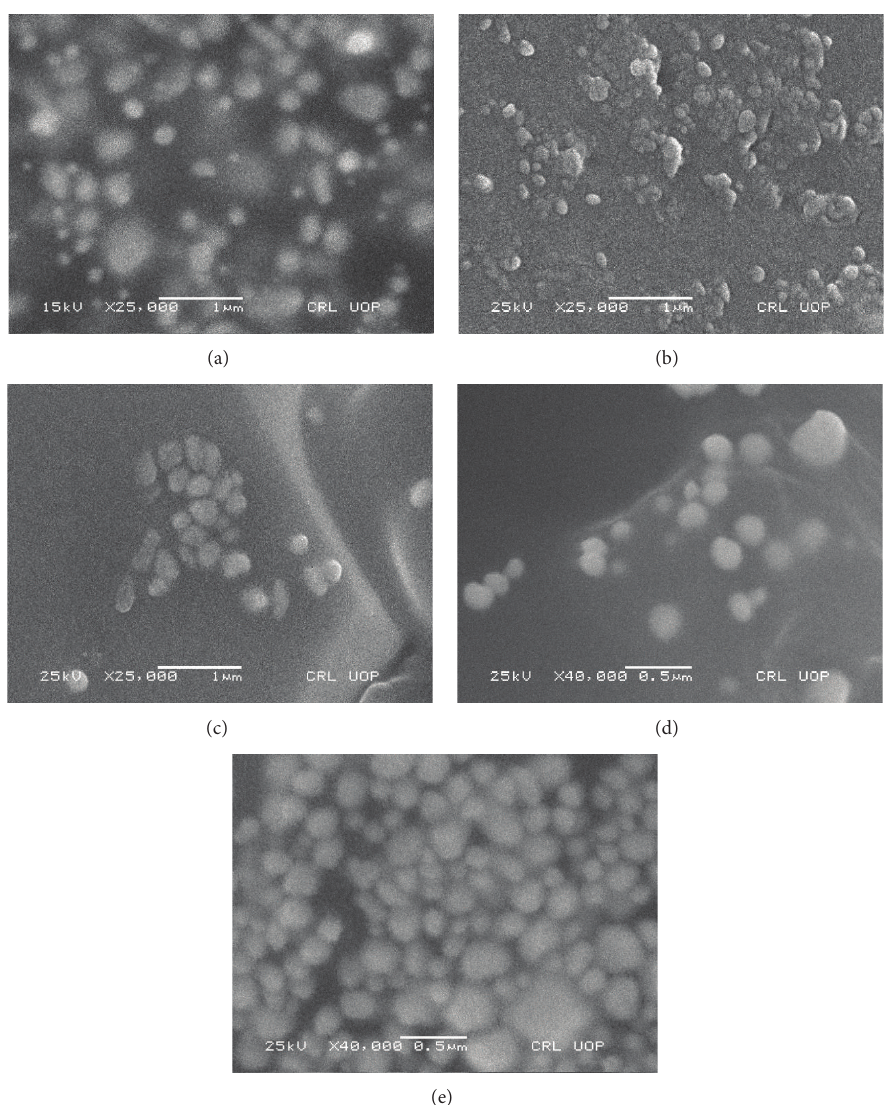
Figure 8: SEM images of (a) Au, (b) Cu, (c) Au-Cu (1:1), (d) Au-Cu (1: 2), and (e) Au-Cu (1: 3) alloy